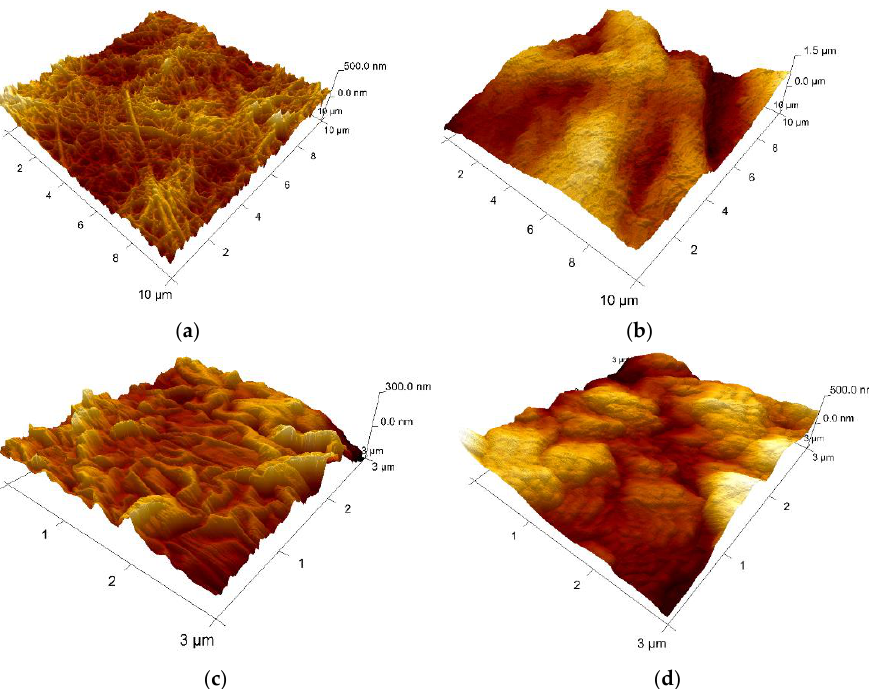
Figure 8. AFM 3D Images on the experimental samples collagen based loaded with gelatin micro- spheres: ( a ) sample A — 0% gelatin (10 μm × 10 μm, z-range = 500 nm); ( b ) sample B — 4% gelatin (10 spheres: ( a ) sample A—0% gelatin (10 µ m × 10 µ m, z-range = 500 nm); ( b ) sample B—4% gelatin μm × 10 μm, z-range = 1.5 µm); ( c ) sample C — 21% gelatin (3 μm × 3 μm, z-range = 300 nm), and ( d ) (10 µ m × 10 µ m, z-range = 1.5 µ m); ( c ) sample C—21% gelatin (3 µ m × 3 µ m, z-range = 300 nm), and sample D — 41% gelatin (3 μm × 3 μm, z-range = 500 nm). ( d ) sample D—41% gelatin (3 µ m × 3 µ m, z-range = 500